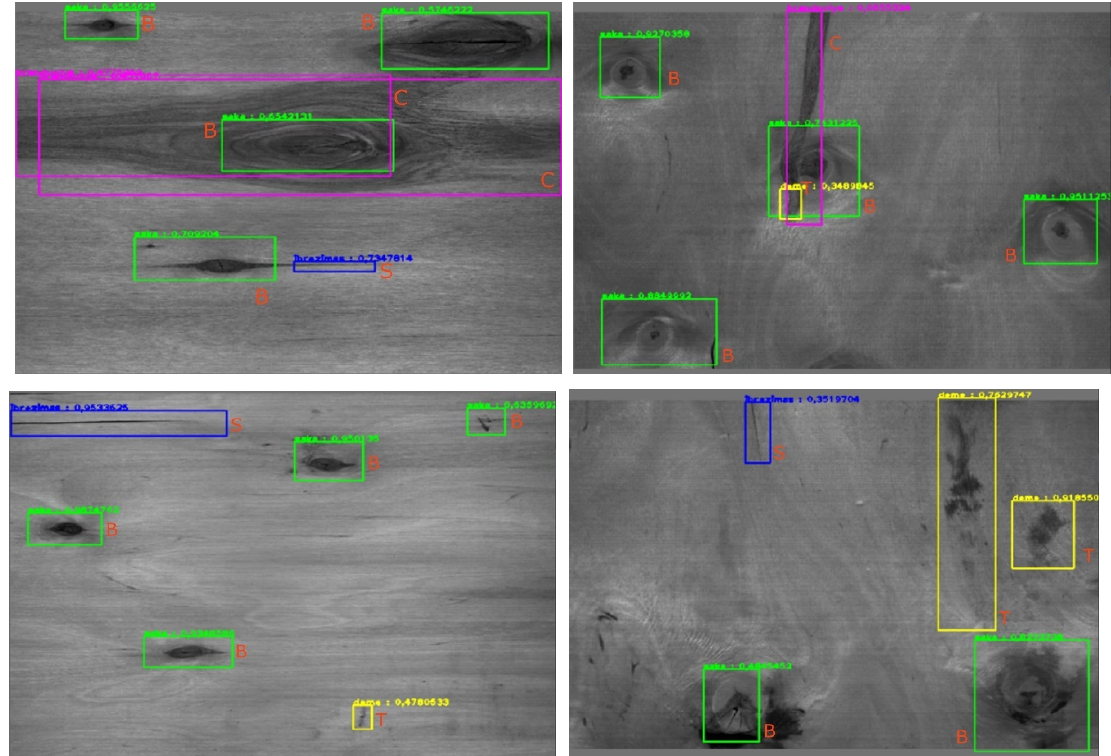
Figure 12. Examples of wood veneer defect classification using faster R-CNN. Branches (B) are labeled in green. Scratches (S) are labeled in blue. Cores (C) are labeled in violet. Stains (T) are labeled in yellow.